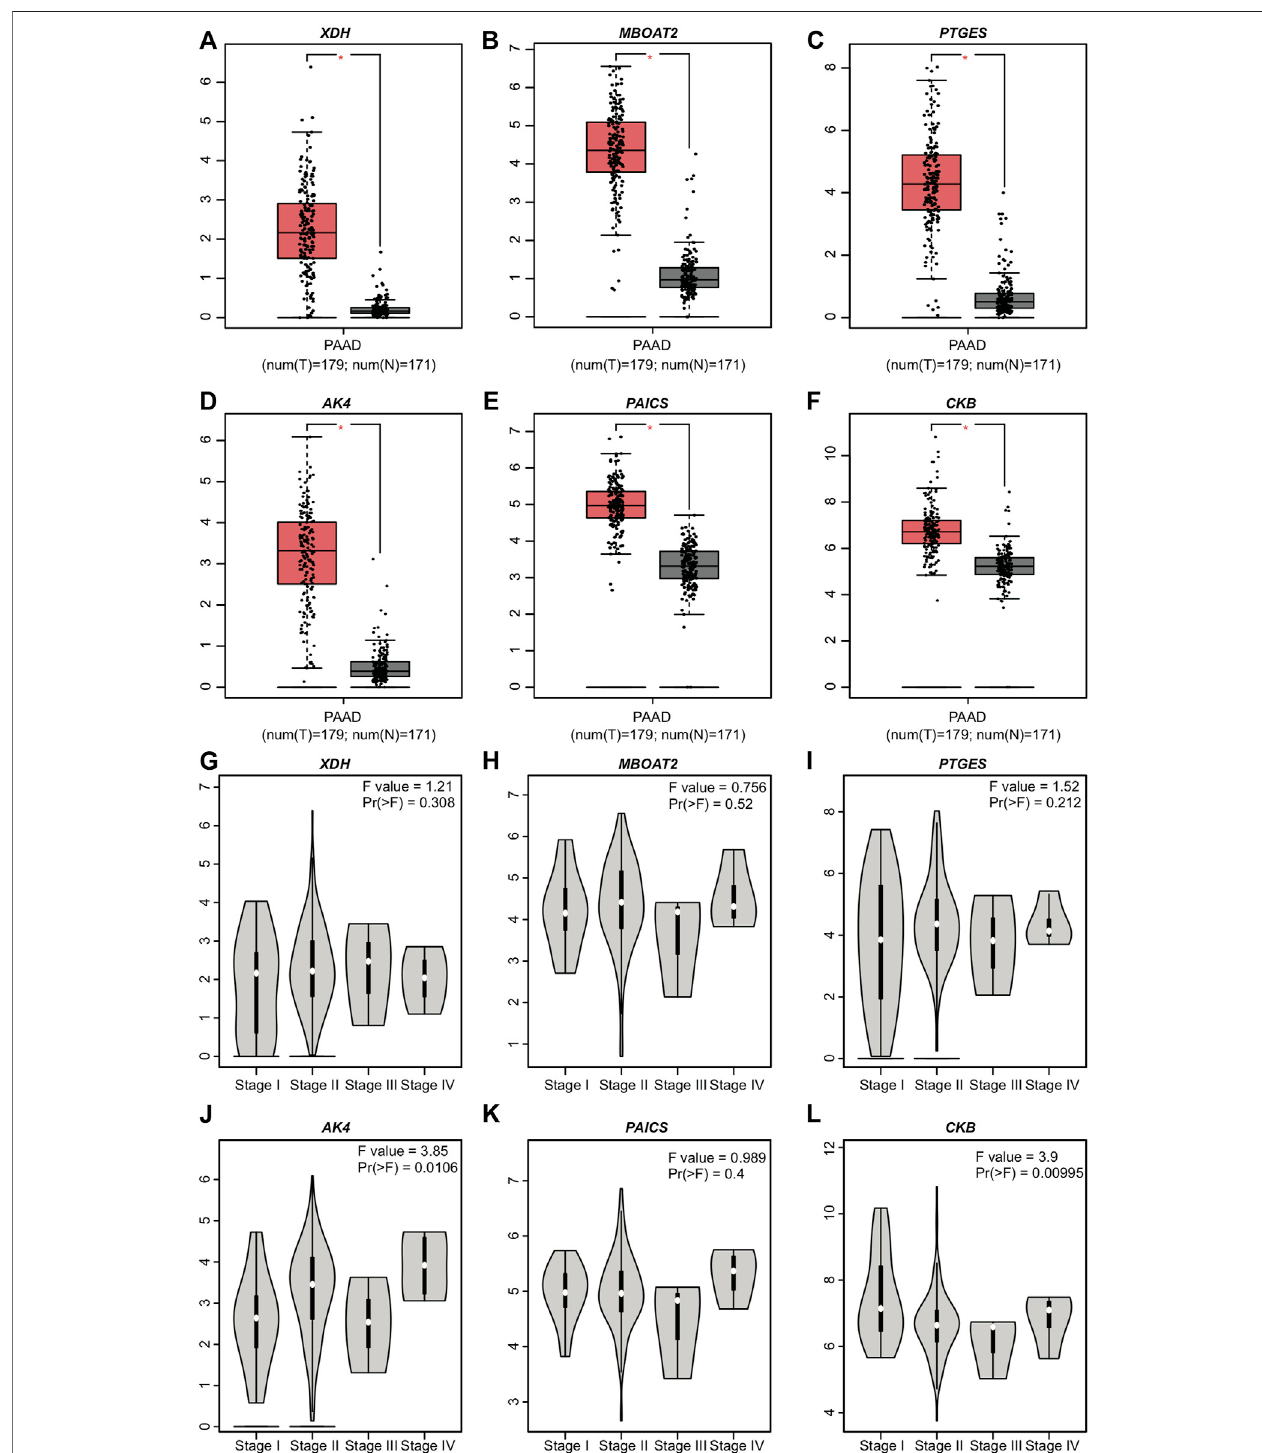
FIGURE 5 | Expression levels of the six PDEMRGs obtained from GEPIA database: (A – F) mRNA expression levels of the six PDEMRGs in PAAD and normal pancreatictissuesobtainedfromGEPIAdatabase(* p ≤ 0.05) — redrepresentsPAADandgrayrepresentsnormalpancreatictissues,and (G – L) mRNAexpressionlevels of the six PDEMRGs in PAAD with disease stage obtained from GEPIA database.